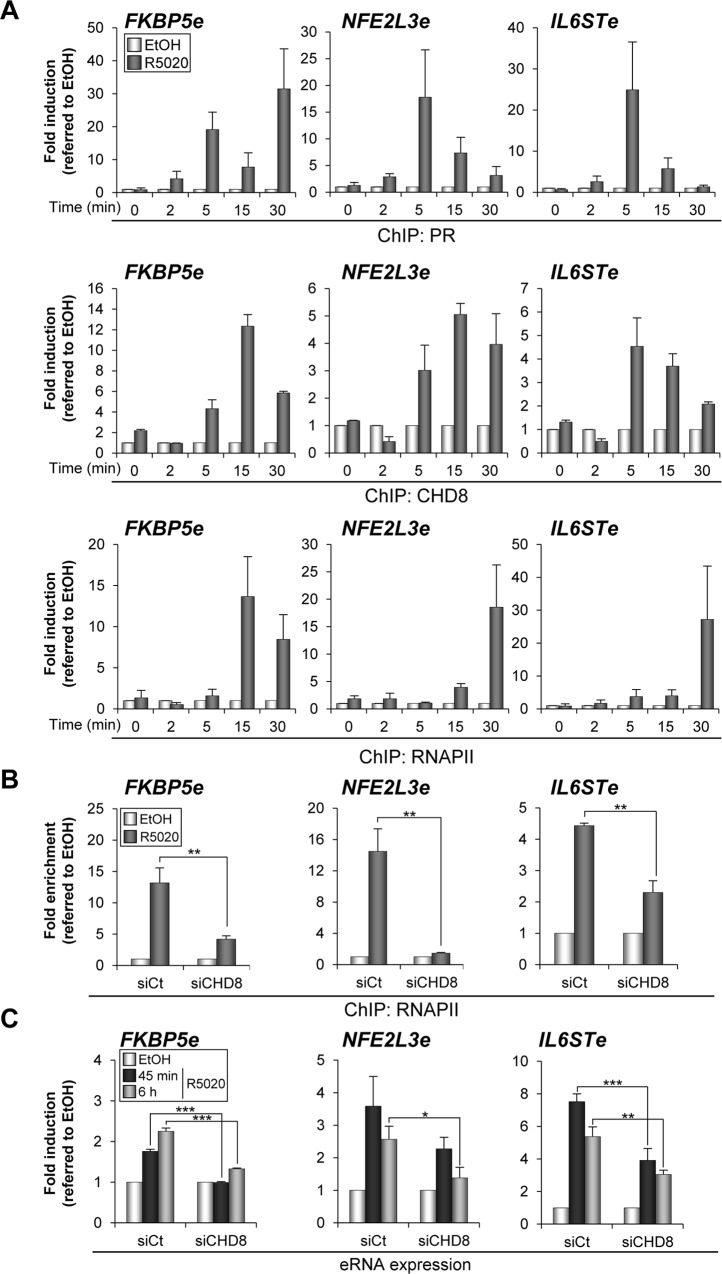
CHD8 is required for RNAPII recruitment and eRNA synthesis at PR enhancers.(A) Time course analysis of PR, CHD8 and RNAPII recruitment to FKBP5e, NFE2L3e and IL6STe enhancers by ChIP. T47D-MTVL cells were stimulated with R5020 (R5020) or vehicle (EtOH) for the indicated times and then processed for ChIP by using antibodies against PR, CHD8 and RNAPII. (B) ChIP analysis of RNAPII enrichment at the indicated enhancers in T47D-MTVL cells transfected with control siRNA (siCt) or siRNA against CHD8 (siCHD8), and then stimulated with R5020 (R5020) or vehicle (EtOH) for 45 min. (C) Expression of enhancer RNAs (eRNA) from the indicated enhancers in T47D-MTVL cells transfected with control siRNA (siCt) or siRNA against CHD8 (siCHD8), and then stimulated with R5020 (R5020) or vehicle (EtOH) for 45 min or 6 h. (A-C) Data are expressed as fold induction relative to the level in ethanol treated cells. Data are the mean of at least n = 6 qPCR reactions from three independent experiments. Error bars represent ± SD values. * p < 0.01; ** p < 0.001; *** p < 0.0001 using Student’s t-test.